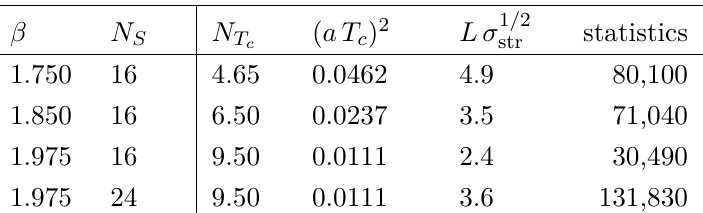
is determined from c